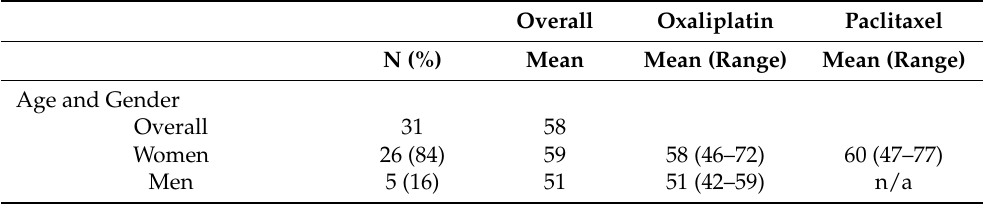
Table 1. Patient